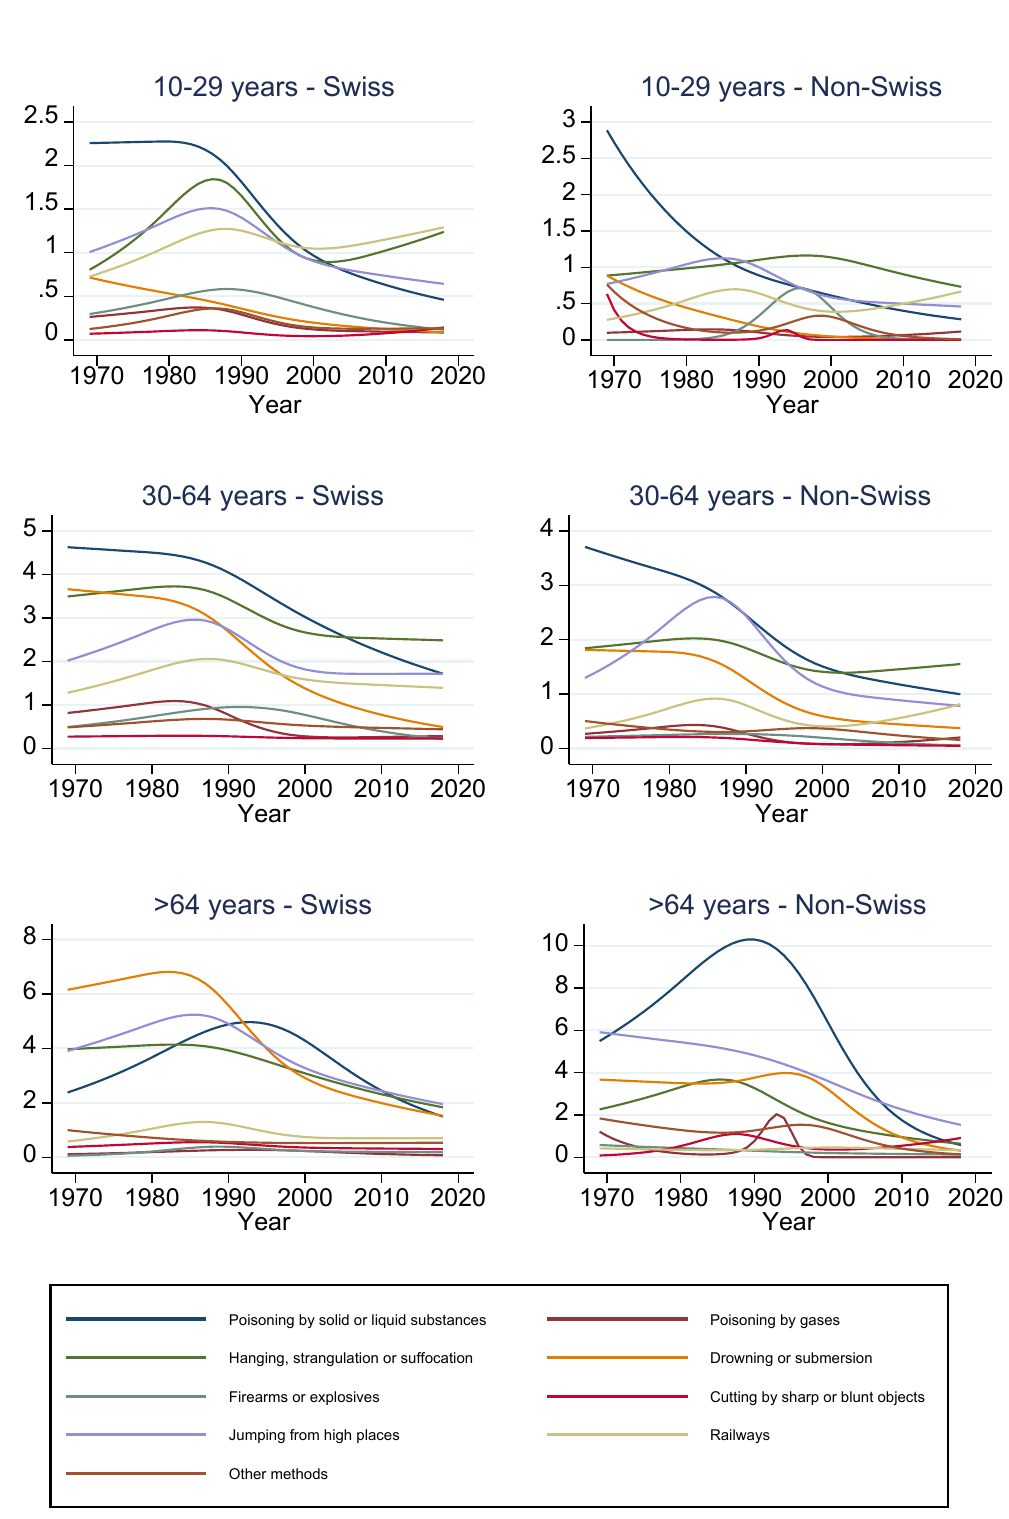
Figure S2. Rates of suicide methods per 100'000 population (person-years) in women.